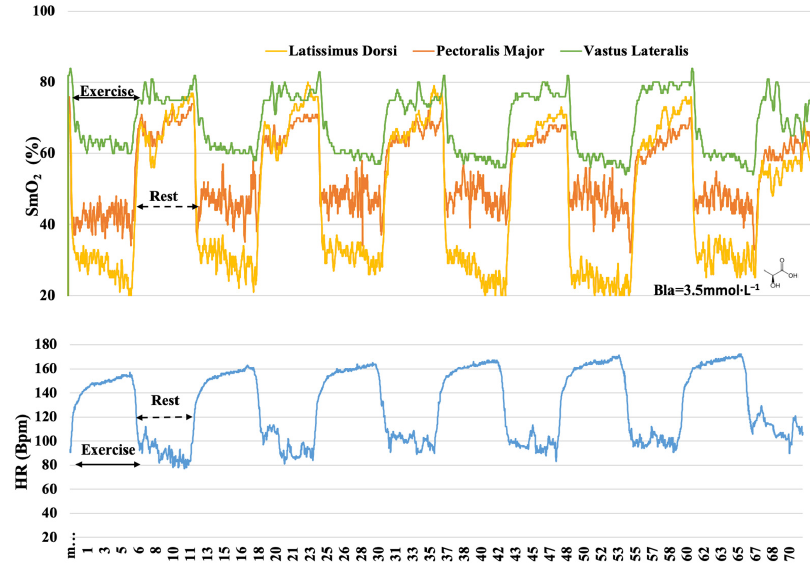
Figure 5. Muscle oxygen saturation (SmO 2 ) kinetics in latissimus dorsi, pectoralis major, and vastus lateralis and heart rate (HR) response during RT protocol; blood lactate (Bla) concentration 3 min after the end of the protocol.